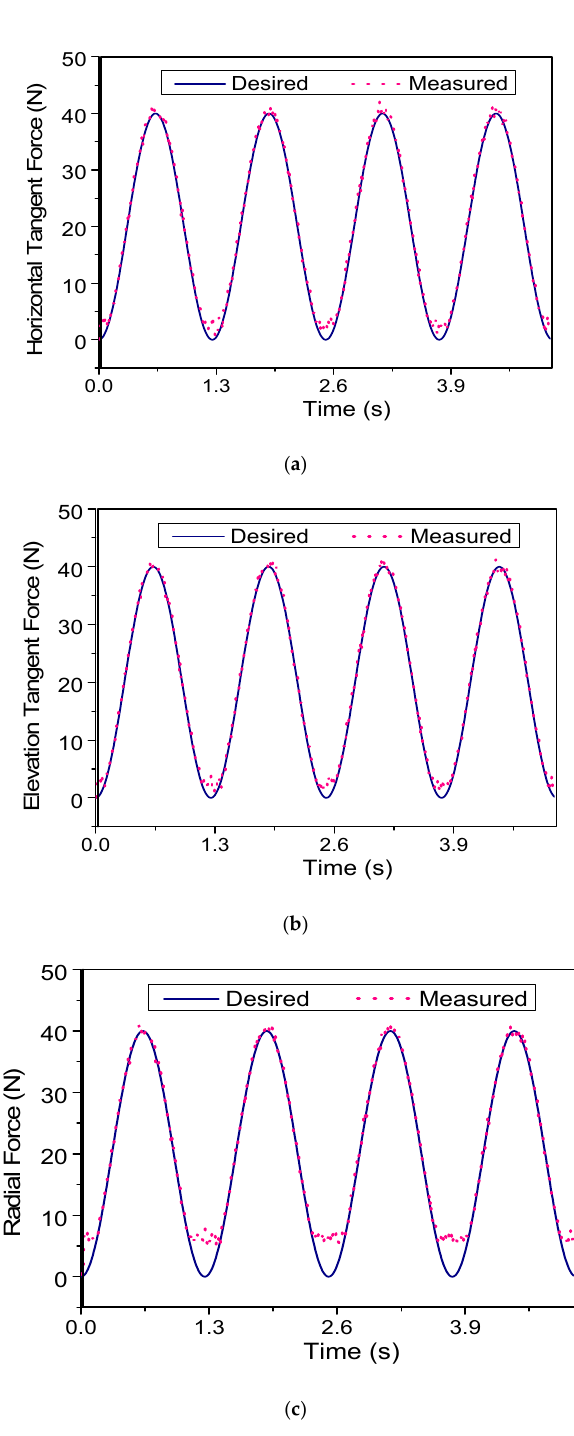
Figure 23. Experimental results on the sinusoidal response of the force feedback system. ( a ) Horizontal force reflection. ( b ) Elevation force reflection. ( c ) Radial force reflection.